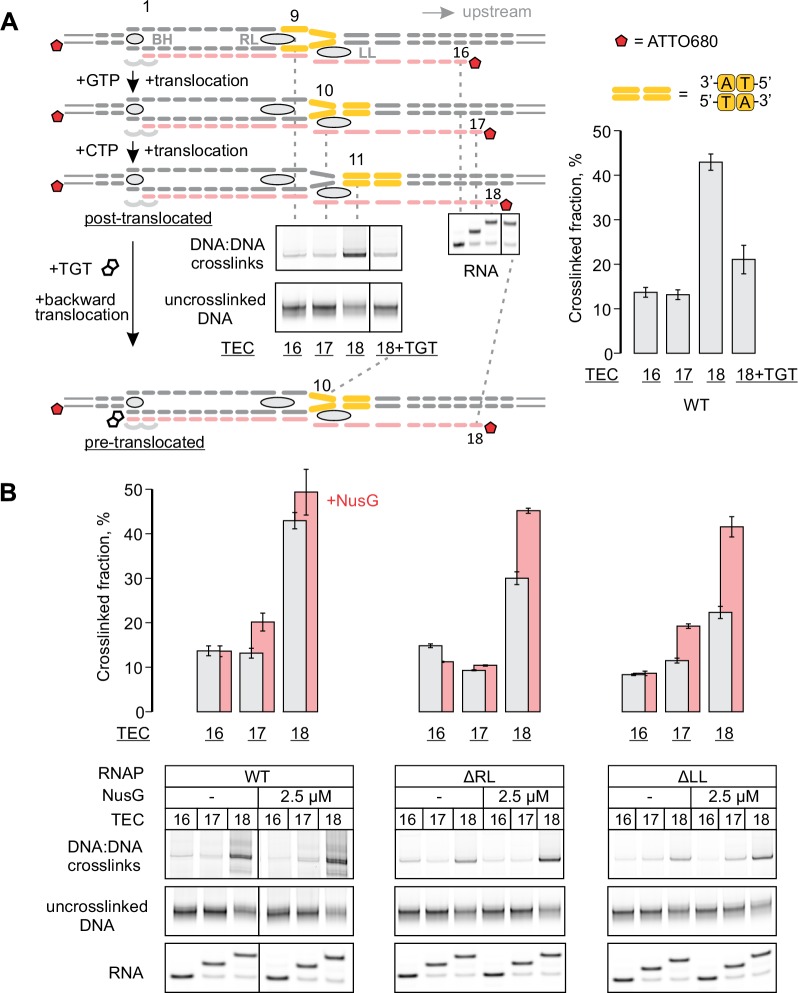
Probing the effects of NusG and deletions of the RNAP domains on the structure of the upstream fork junction by DNA:DNA photocrosslinking with 8-methoxypsoralen (8-MP).(A) TECs containing the unique 8-MP intercalation site were supplemented with 8-MP, walked by up to three nucleotides, supplemented with 5 µM TGT (where indicated) and illuminated with the UV light. (B) DNA:DNA crosslinking in TECs formed by the wild-type and altered RNAPs in the absence (grey bars) and presence (red bars) of NusG. Error bars indicate the range of duplicate measurements or SDs of several measurements (Table 5). The gel panels were spliced from the same gel and the pixel counts were linearly scaled to span the full 8 bit grayscale range within each panel. Joined panels have the same scaling.